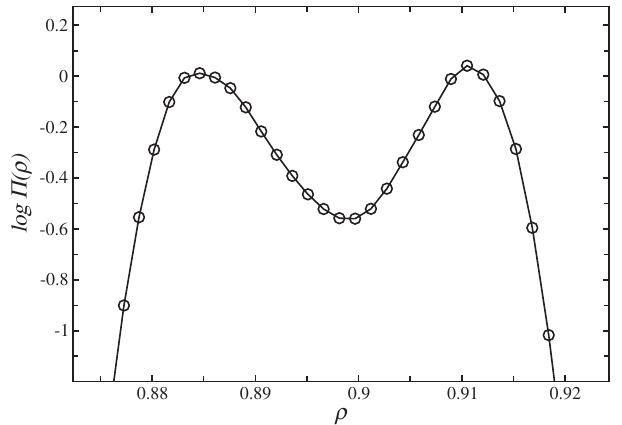
FIG. 14. Probability distribution of the density for one-com- ponent hard disks. The symbols are the logarithm of the σ 2 ≈ 9 . 09 , where the probability distribution log Π ð ρ Þ at β P coex areas under the two peaks are equal. The two phases have an average of ρ ¼ 0 . 884 and ρ ¼ 0 . 907 , respectively. Π ð ρ Þ is not normalized in this